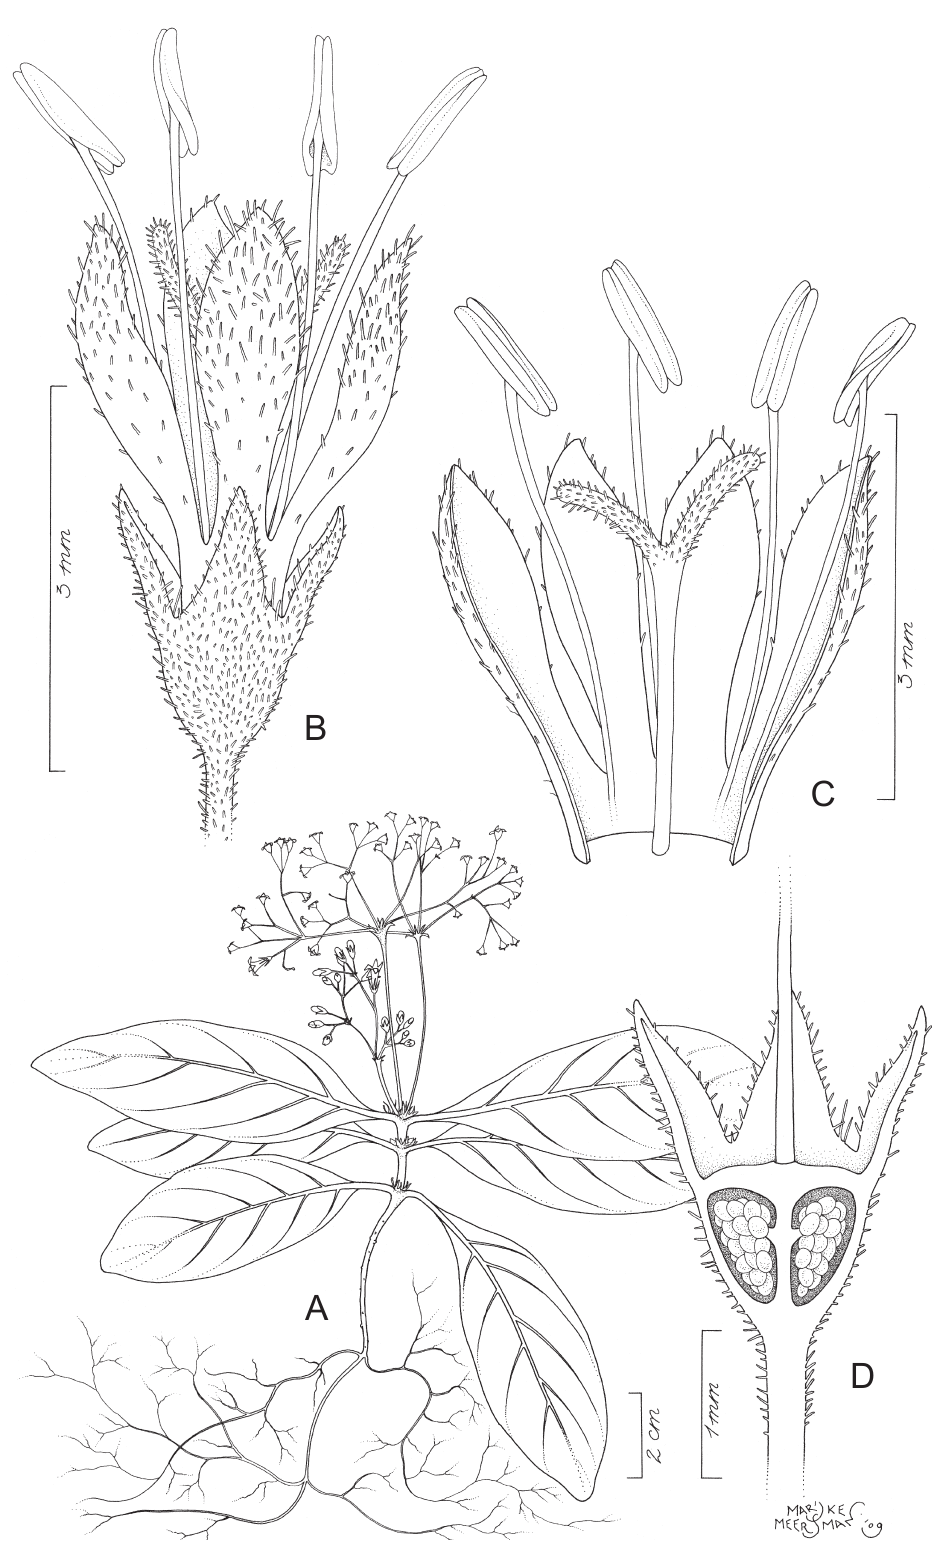
Fig. 1. Astiella antongilensis Groeninckx sp. nov. A . Habit. B . Brevistylous flower. C . Open brevistylous flower. D . Ovary dissected to show placentation. Drawn by Marijke Meersman. All from Perrier de la Bâthie 3749 (P)